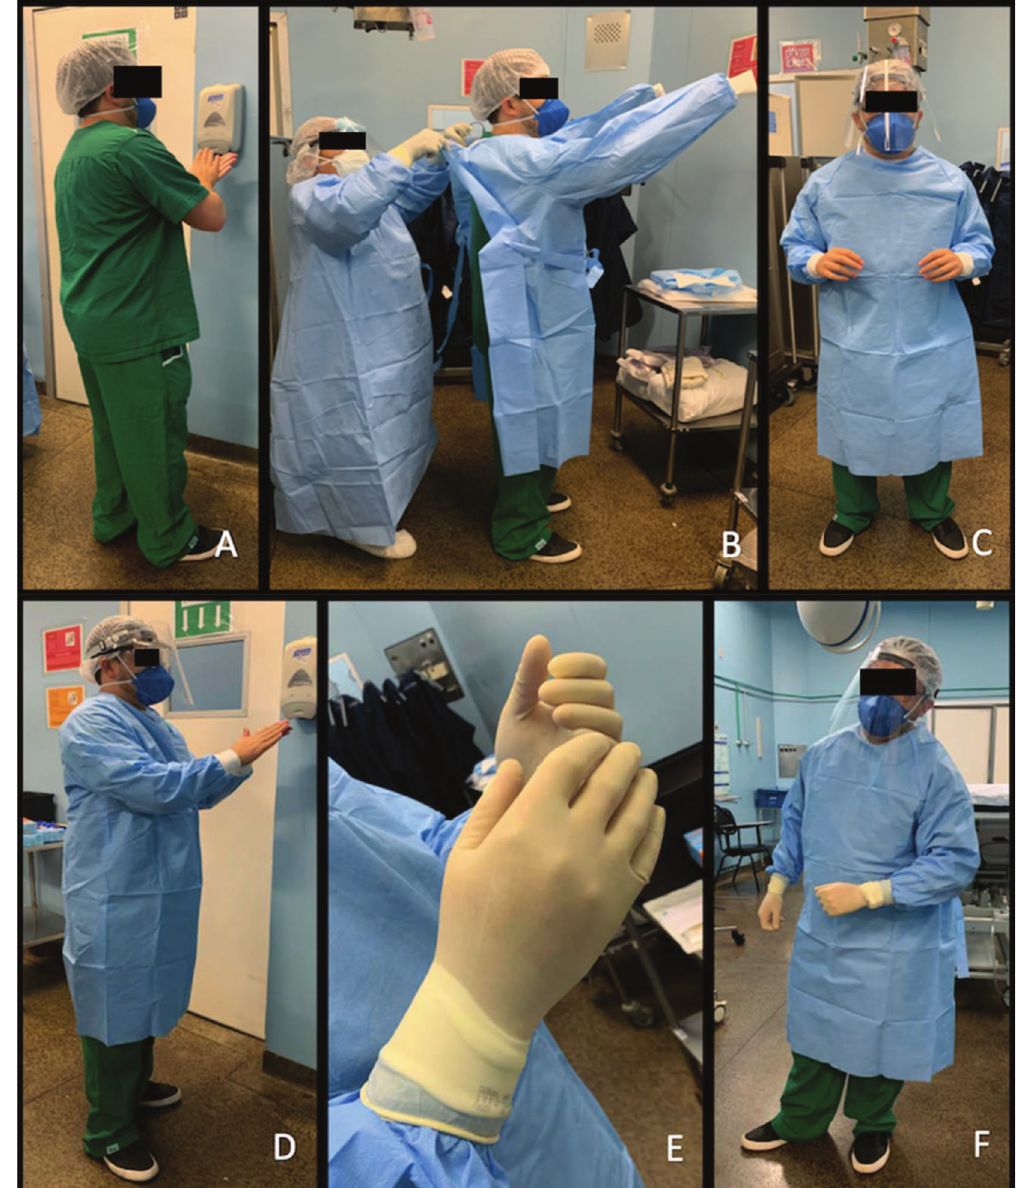
Figure 3 - Guidance for Donning PPE to be used by Healthcare Professionals during Endoscopic Procedures for Patients with Confirmed/ Under Investigation for COVID-19. First, the healthcare professional dons scrubs, closed and waterproof shoes, N95 or PPF 2 mask, and hairnet in the locker room. Only then should the healthcare professional enter the surgical center. Before entering the operating room, the healthcare professional must wear PPE in the dressing room (donning/doffing room): A. hand hygiene; B. don the long-sleeved waterproof isolation gown; C. put on goggles and face shield; D. hand hygiene; and E. put on gloves that fully cover provider ’ s wrist. F. The healthcare professional may now enter the operating room. Abbreviations: PPE, personal protective equipment; COVID-19, coronavirus disease